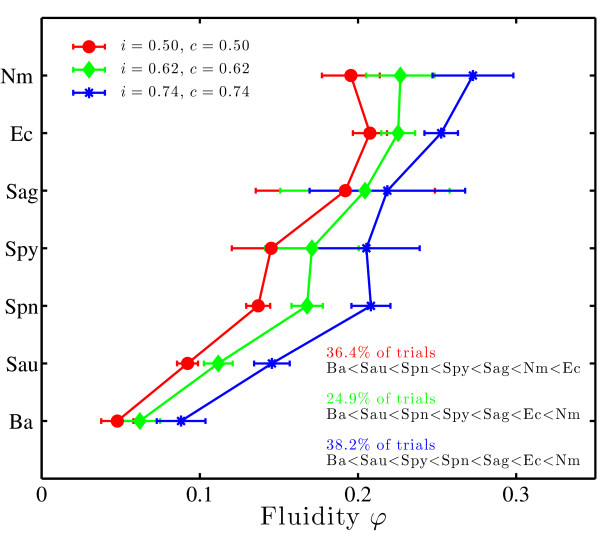
Estimates of mean and standard deviation of fluidity for 7 multiply-sequenced species. Mean and standard deviation of φ are calculated for B. anthracis (Ba), E. coli (Ec), and N. meningitides Nm). Staph. aureus (Sa), Strep. agalactiae (Sag). Strep. pneumoniae (Spn), and Strep. pyogenes (Spy) as a function of alignment parameters. Although fluidity increases with higher values of identity (i) and coverage (c) (see Additional file 1, Figure S5), only three rank-orderings of fluidity (of 5040 possible orderings) are found in 224/225 combinations of alignment parameters.